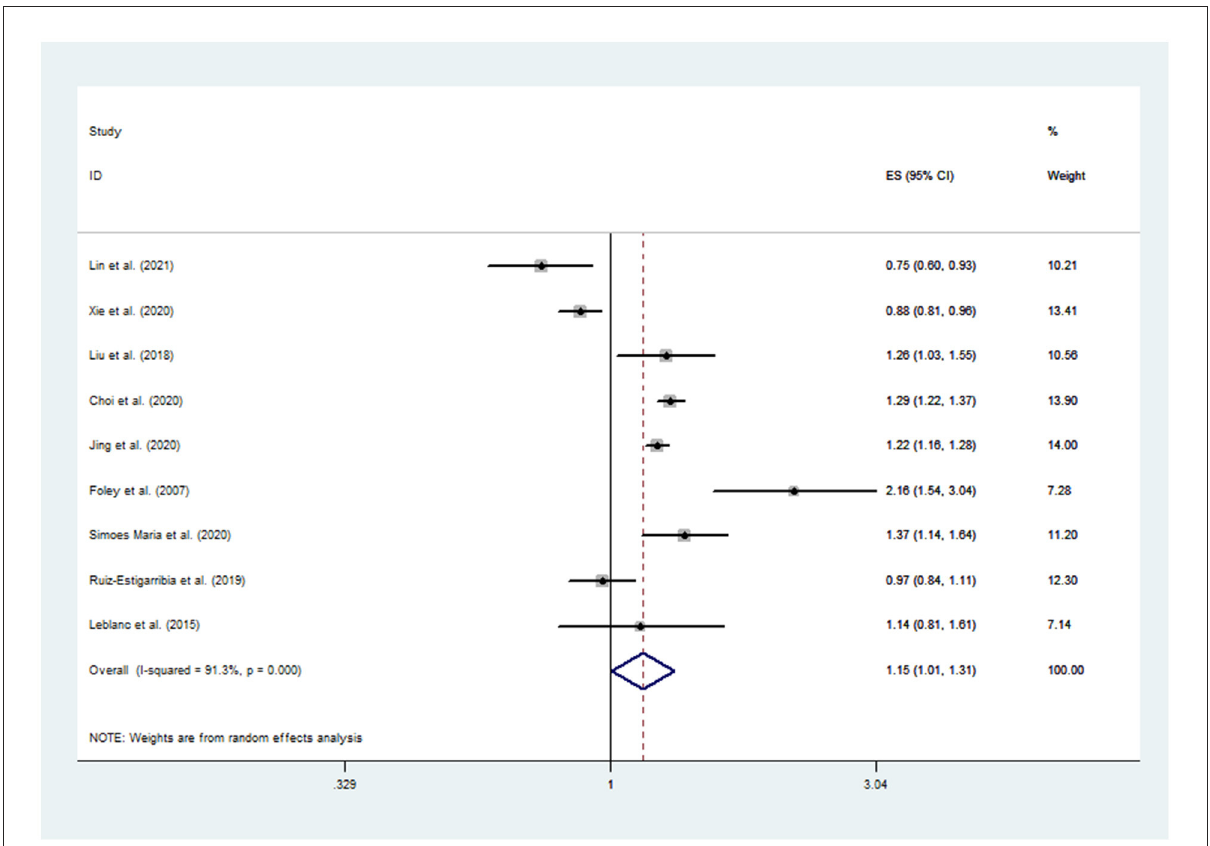
FIGURE2 Forest plot of the association between daytime napping and the risk of